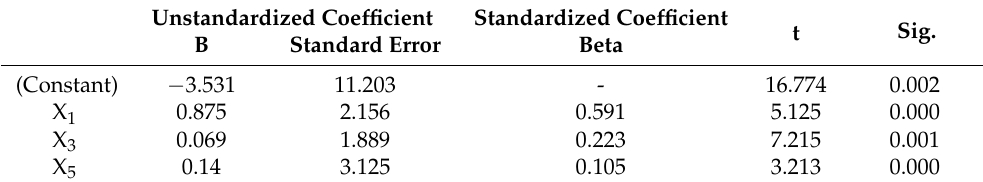
Table A4. Coefficient of regression model b